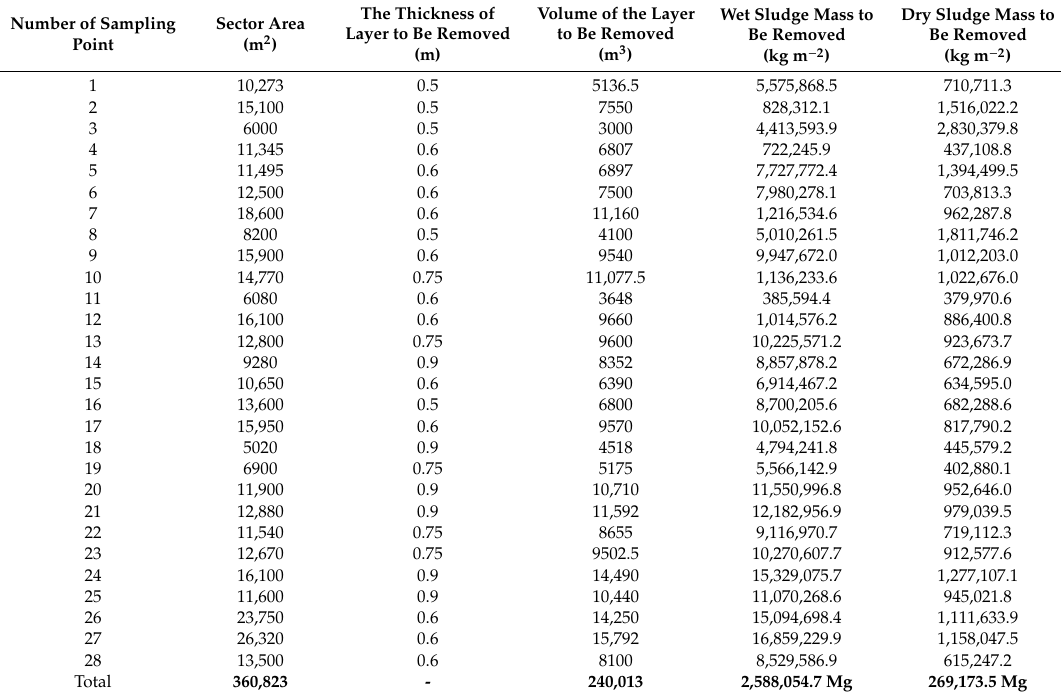
Table 4. Characteristics of physical parameters of bottom sediments with respect to the spatial volume balance and the mass of potential output to be removed.